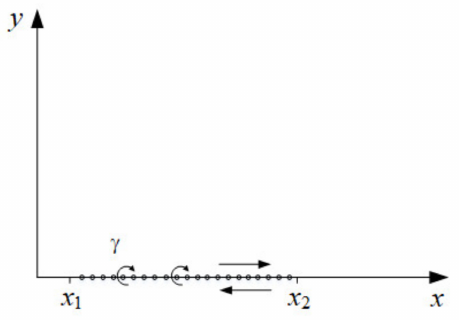
Figure 1. Finite vortex sheet along the x -axis.